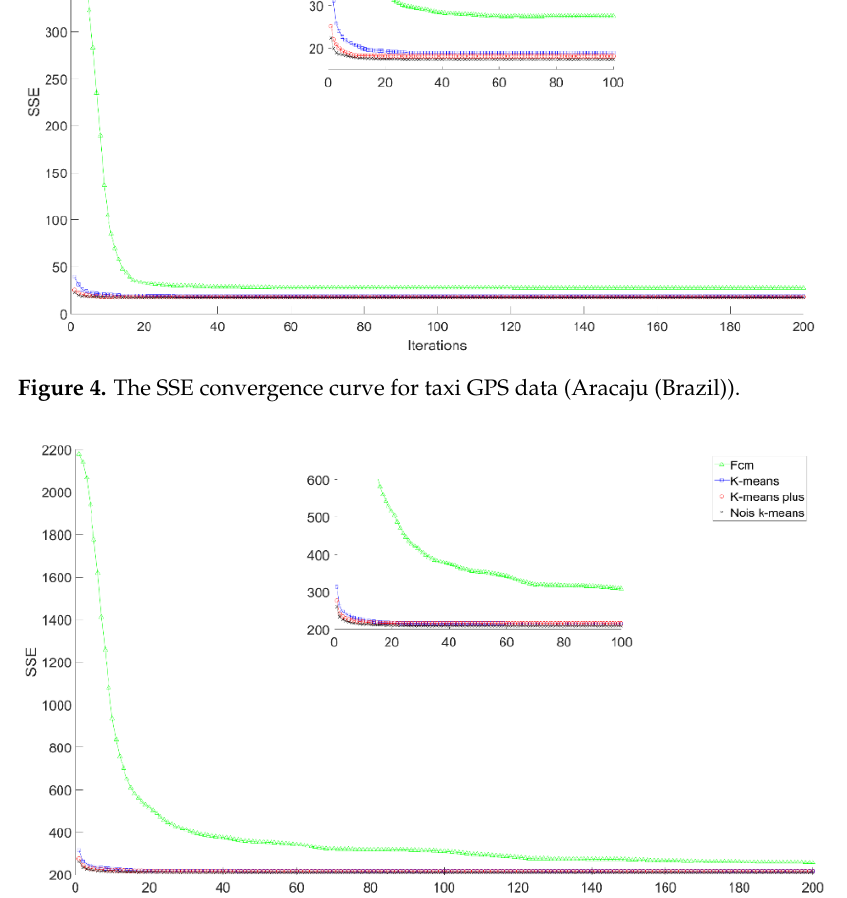
Figure 7. The SSE convergence curve for taxi GPS data (Chongqing (China)). Figure 8. The SSE convergence curve for taxi GPS data (Beijing (China)). As can be seen from Figures 4–8, all comparative clustering algorithms, except for FCM, could complete the convergence by iterating about 10 times, which shows that the proposed noise-based K-means clustering algorithm is feasible and suitable for basic par- tition clustering algorithms. 4.4. Visual Presentation of Urban Hotspots In order to more intuitively display the capture of urban hotspots by clustering algo- rithm, a visual presentation in Amap system is used in this paper. That is, the captured